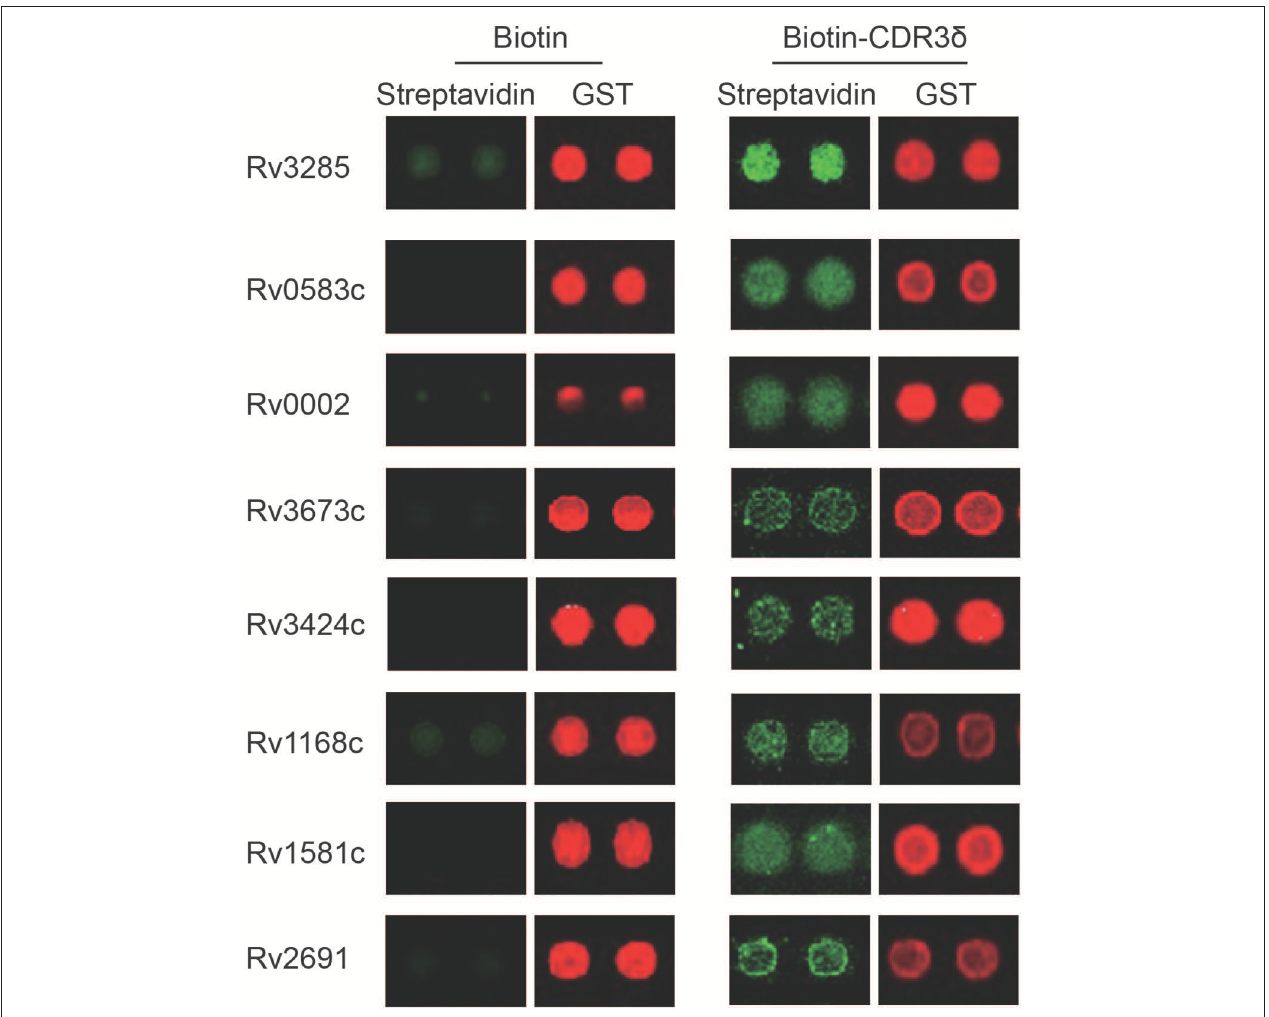
FIGURE 5 | Mtb antigen-related protein ligands bound to CDR3 δ peptides screened using the Mtb proteome chip. Red fluorescence marks the GST tag, indicating the presence of the corresponding protein on the chip. Green fluorescence marks the binding of the probe. Lines 1, 3, 5, and 7 act as the bio-CDR3 peptide, lines 2, 4, 6, and 8 act as the biotin